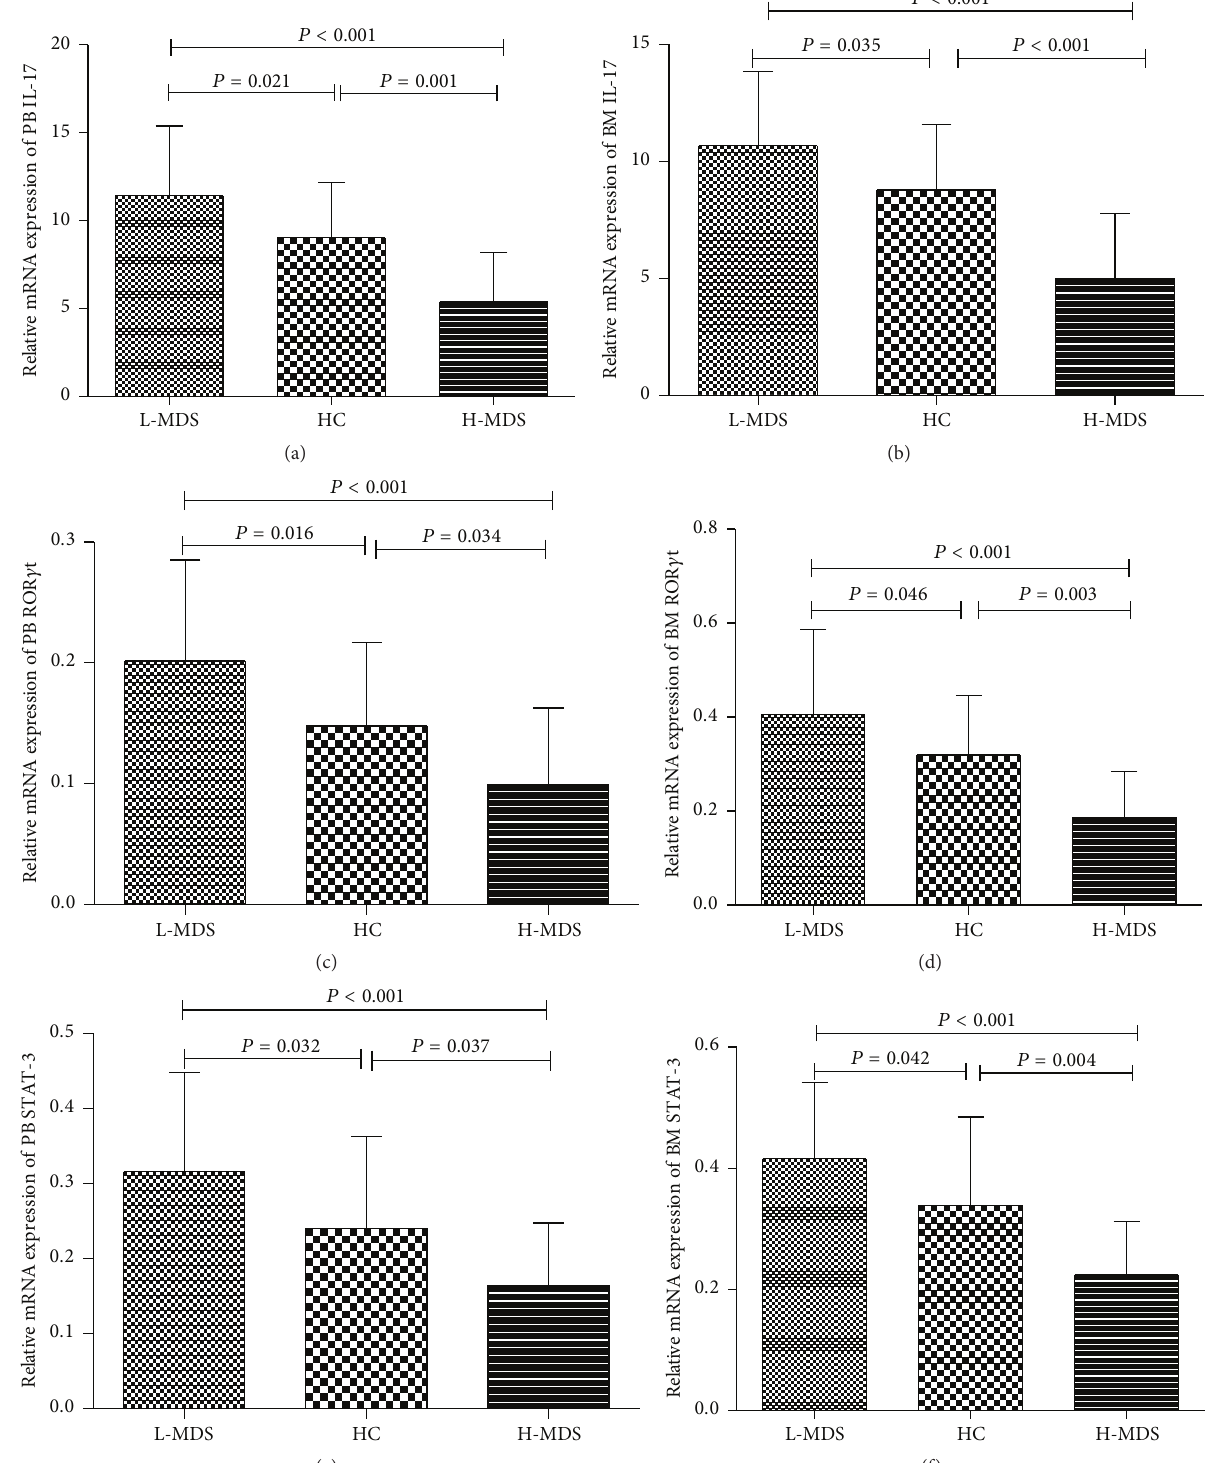
Figure 5: Critical transcription factors of Th17 cells are differentially expressed in MDS patients and controls. mRNA levels of IL-17 (a-b), ROR 𝛾 t (c-d), and STAT-3 (e-f) in PB and BM from L-MDS, HC, and H-MDS groups were determined by